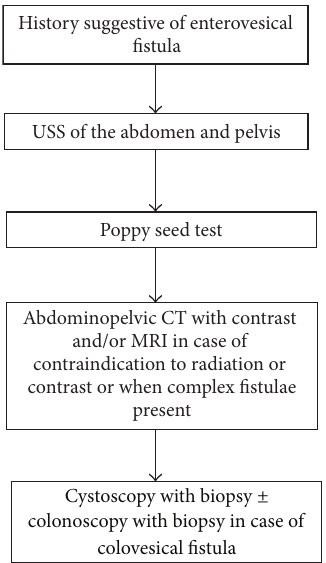
Figure 1: Diagnostic imaging and procedures algorithm for enter- ovesical